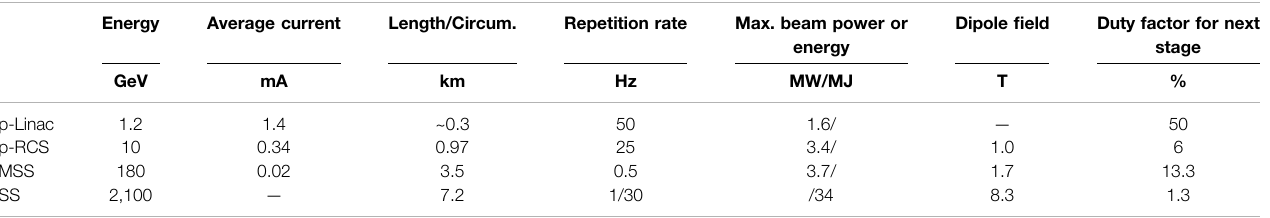
TABLE 5 | Main parameters for the injector chain at